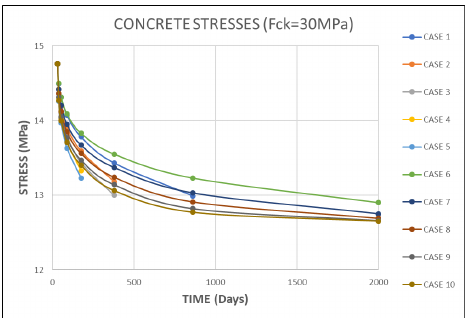
Figure 14. C30 Concrete stresses evolution by creep.